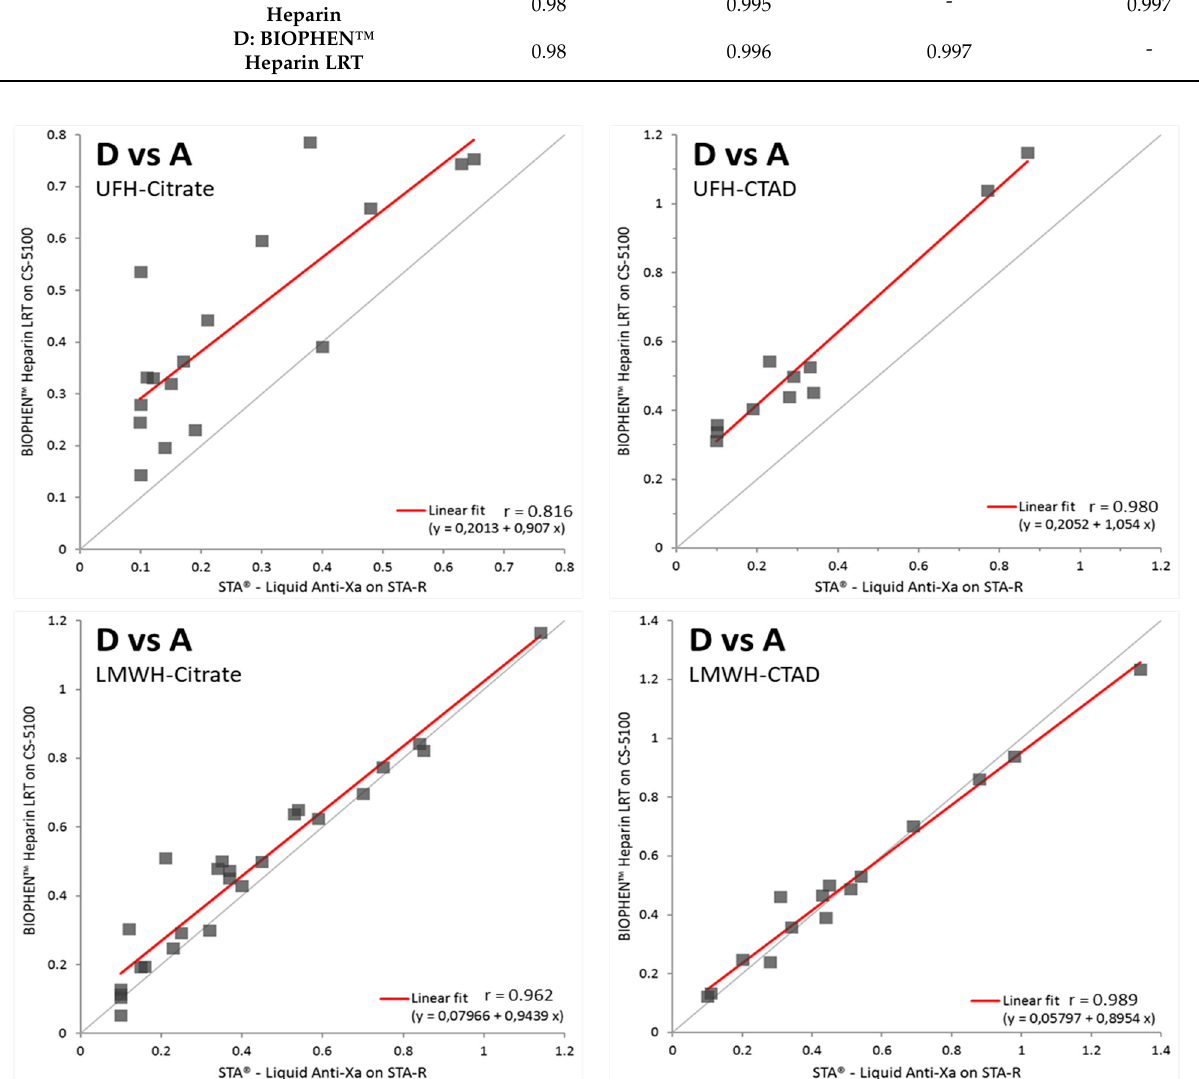
Figure 4. Correlation diagrams between the anti-FXa reagent designed without dextran sulfate (reagent A) and another one with (reagent D) for the different subgroups of tested samples: UFH-citrate, LMWH-citrate, UFH-CTAD, LMWH-CTAD. The correlation is poor for citrate anticoagulated samples, and concentrations are underestimated, especially for UFH, whilst it is acceptable for UFH or LMWH CTAD anticoagulated plasmas, shown by the ordinary least square fit line close to the identity line.